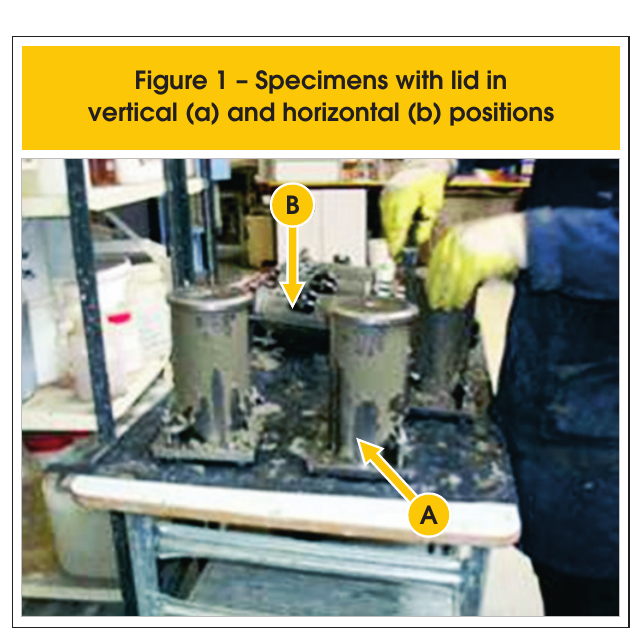
Figure 1 – Specimens with lid in vertical (a) and horizontal (b)